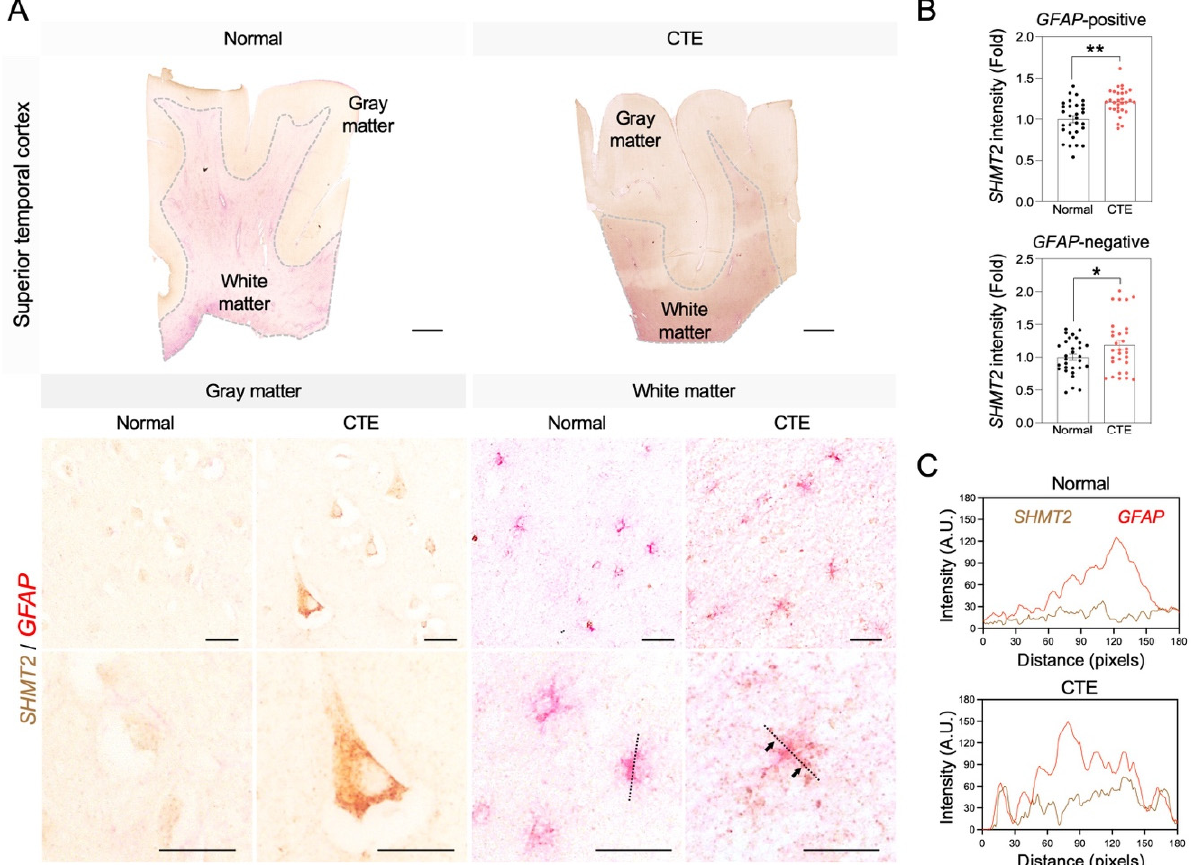
Figure 6. SHMT2 immunoreactivity is significantly increased in the cortex of CTE patients. ( A ) SHMT2 (brown) was co-localized with GFAP (red) in the cortical white matter of CTE patients. White dotted lines indicate the border of white matter and gray matter. Black dotted lines were drawn to analyze the colocalization of SHMT2 and GFAP. Black arrows indicate co-localization foci of SHMT2 with GFAP. Scale bars: top 2 mm, middle 20 µ m, bottom 20 µ m. ( B ) SHMT2 immunoreac- tivity was significantly increased in GFAP-positive astrocytes of the white matter and also found in GFAP-negative cells of the gray matter in CTE patients (cell counting: a total of 30 cells (10 cells/case); Normal, N = 3; CTE, N = 3). Significantly different from the normal subjects at * p < 0.05; ** p < 0.01. ( C ) Co-localization analysis showed that SHMT2 and GFAP double immunoreactivity was markedly increased in the cortical white matter of CTE